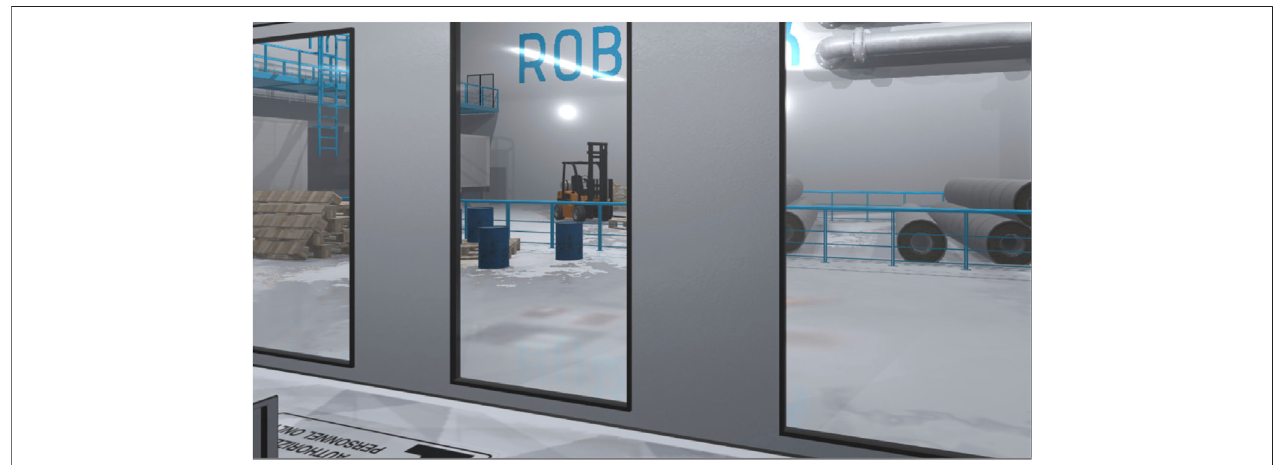
FIGURE 1 | The virtual representation of an industry environment served as the background of the workplace arrangement. Equipped with appropriate props and sound cues, this backdrop aimed to provide the context of the setting and facilitate the immersion of the experimental study.